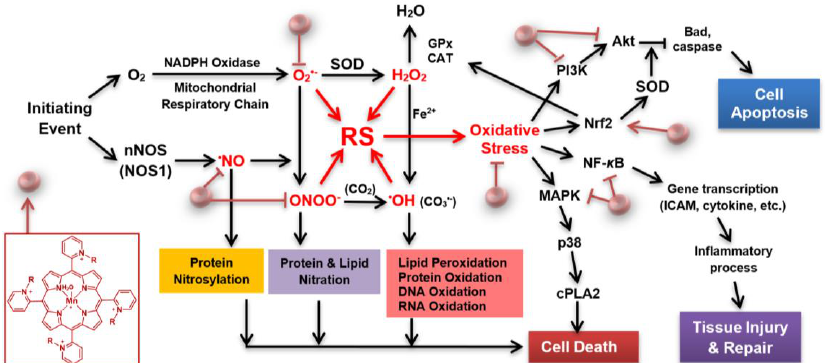
GPx (glutathione peroxidase), nNOS (neuronal nitric oxide synthase), BAD (pro-apoptotic protein from Bcl-2 family of proteins). Modified from